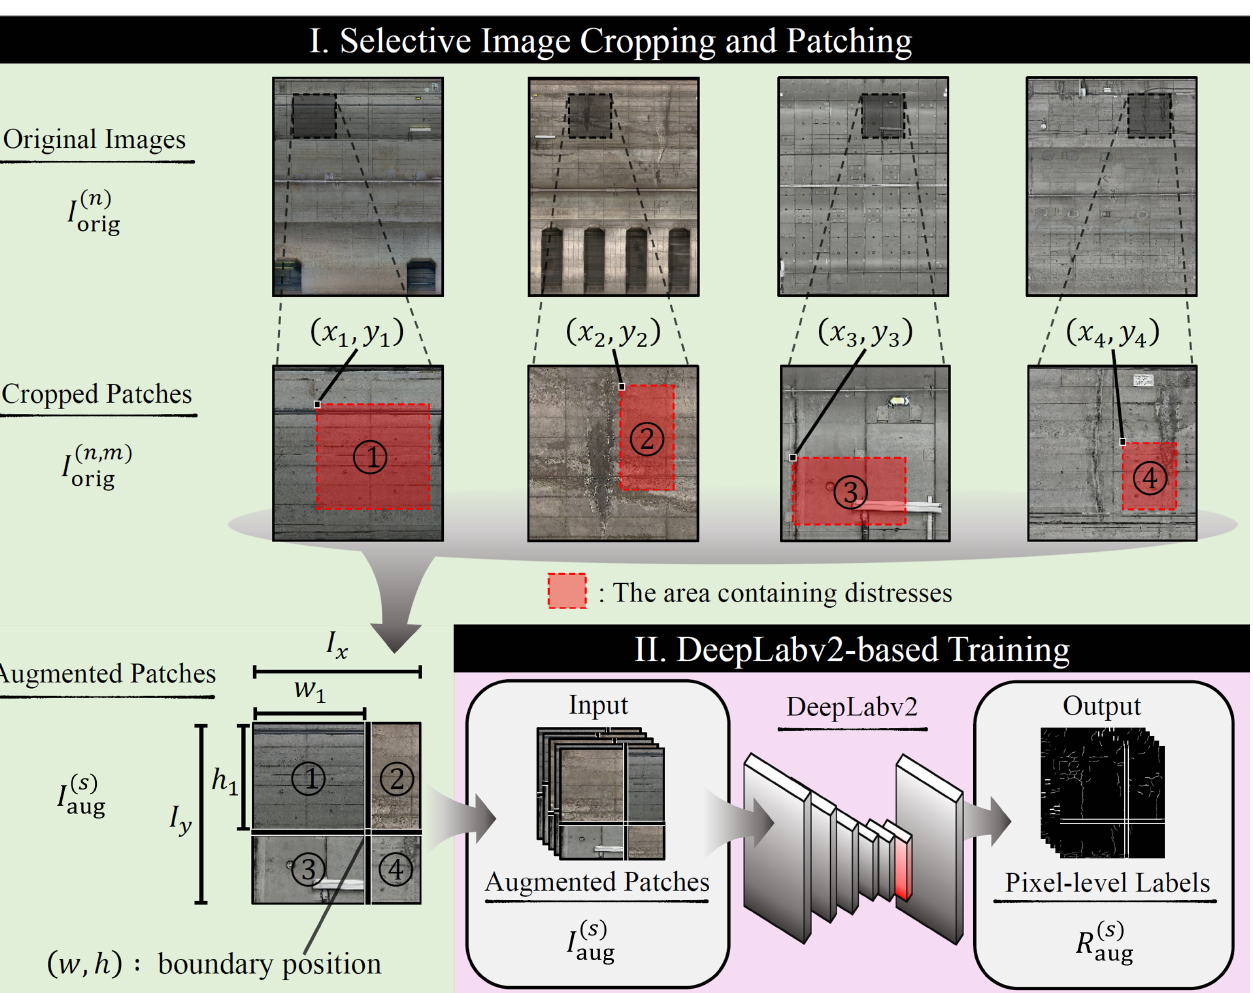
Figure 1. Overview of the proposed method for detecting regions of distress in subway